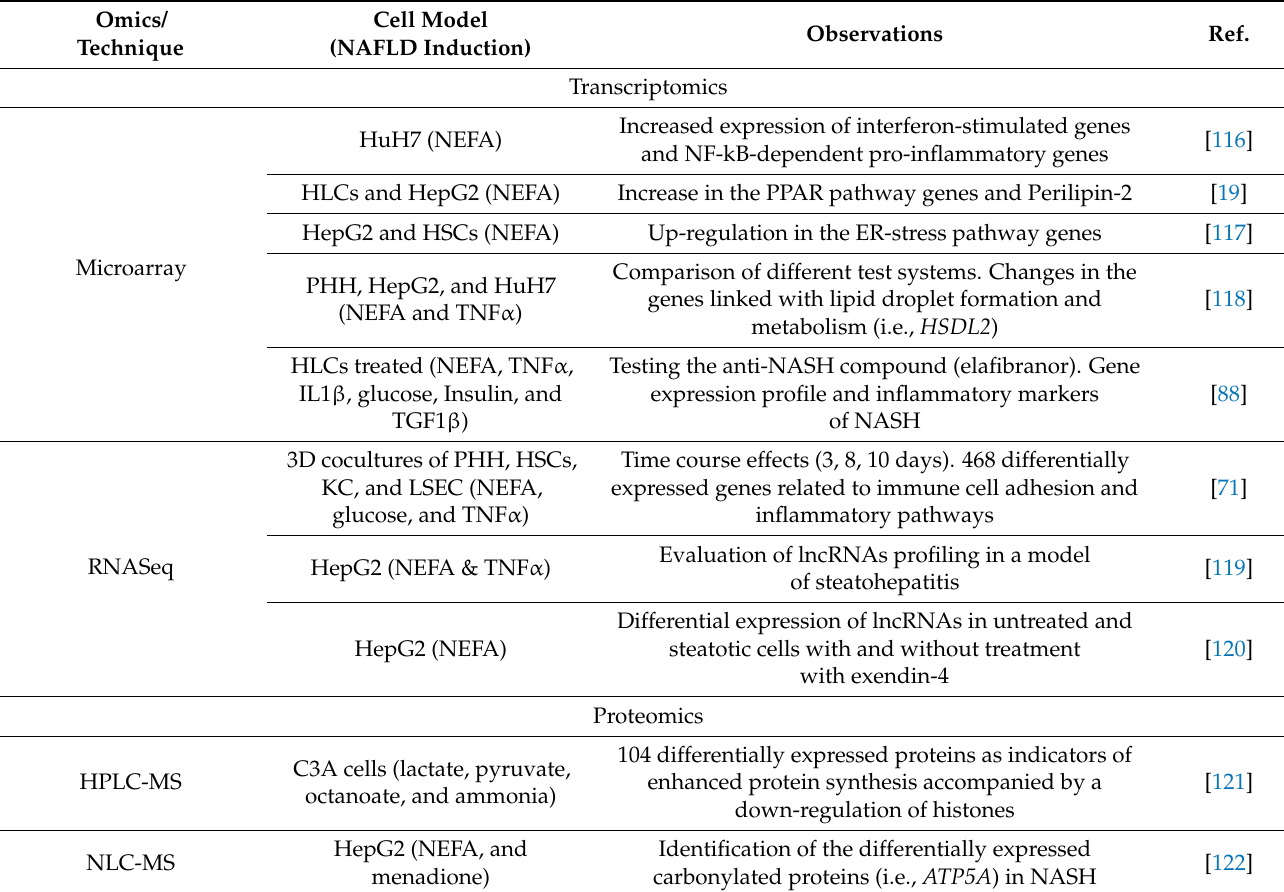
Table 3. Omics approaches for the in vitro modeling of